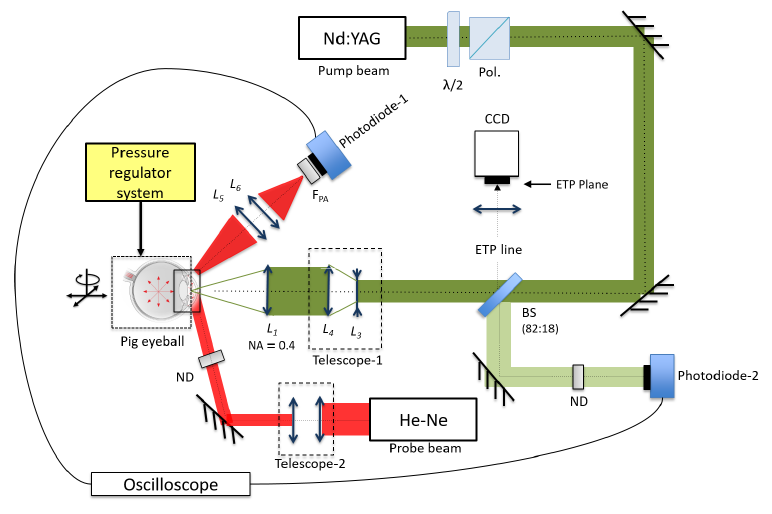
Figure 2. Experimental setup for the spatial transmittance modulation (STM) technique and the equivalent target plane (ETP) system in ex vivo pig eyes.